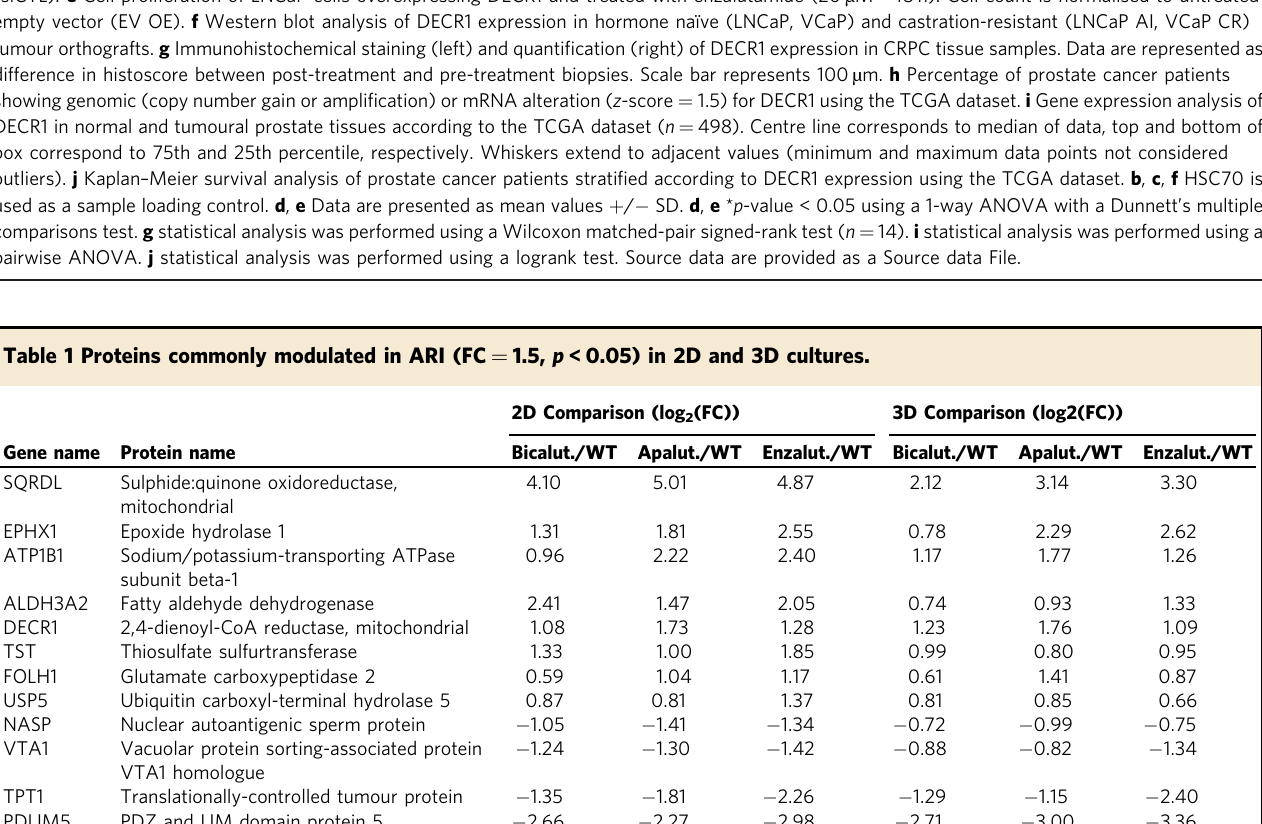
Fig. 5 DECR1 is a potential target for CRPC. a Venn diagrams highlighting proteins commonly modulated ( p -value < 0.05, FC > 1.5) in ARI-resistant cells cultured in 2D and 3D conditions. Upregulated proteins are on top; downregulated proteins are into brackets. b Western blot analysis of DECR1 expression in WT and ARI-resistant LNCaP cells. c Western blot analysis of DECR1 expression in AR + prostate cancer cells following acute AR inhibition for 48 h. d Cell proliferation of C4-2 cells silenced for DECR1 expression and treated with enzalutamide (20 µ M — 48 h). Cell count is normalised to untreated control (siCTL). e Cell proliferation of LNCaP cells overexpressing DECR1 and treated with enzalutamide (20 µ M — 48 h). Cell count is normalised to untreated empty vector (EV OE). f Western blot analysis of DECR1 expression in hormone naïve (LNCaP, VCaP) and castration-resistant (LNCaP AI, VCaP